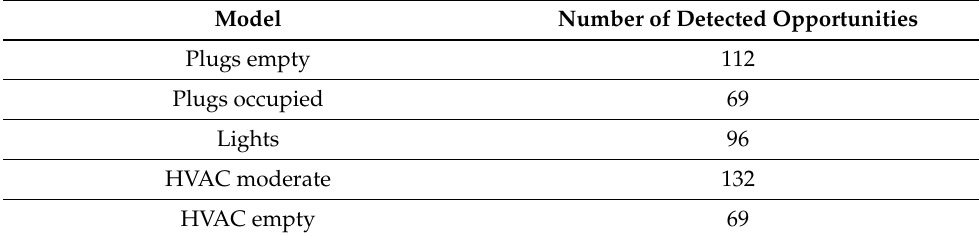
Table 18. Detected opportunities by Behaviour Predictor in 211 test